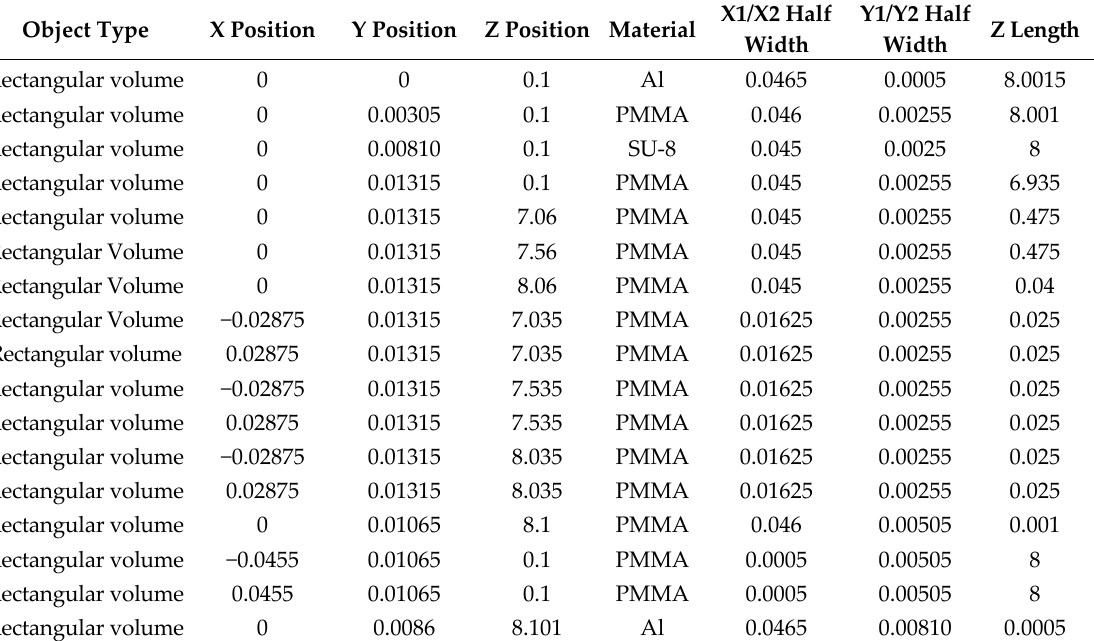
Table 1. Parameters used for implementation of the SU-8 based waveguide ( Zemax ® units—millimeters).